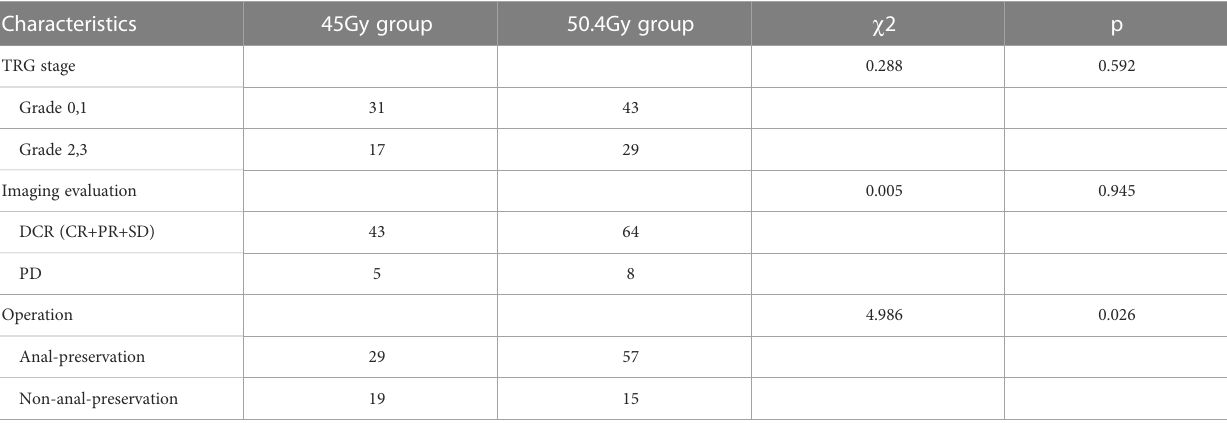
TABLE 2 Ef fi cacy evaluation of